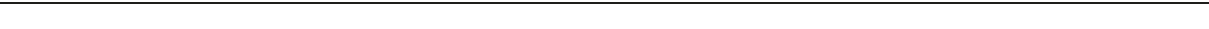
Fig. 8 CDYL inhibits seizure susceptibility and latent period duration in temporal lobe epilepsy. a Examples of in vivo EEG recordings obtained from